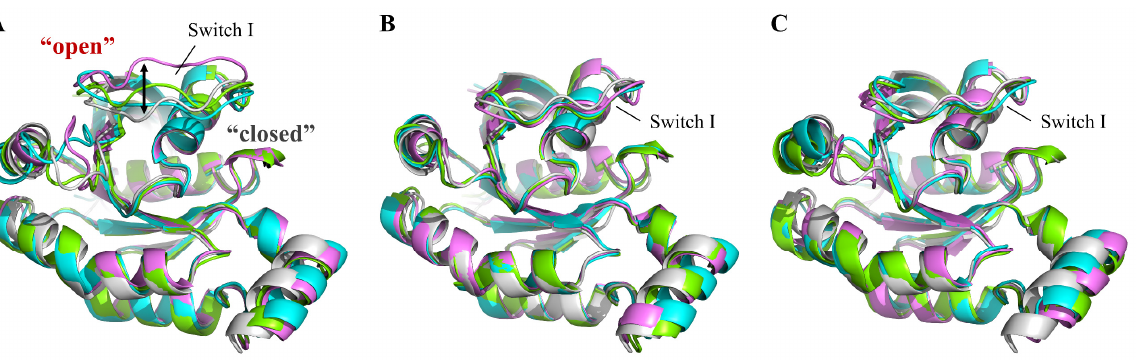
Figure 3. Superimposition of the top-three cluster conformations (cluster1—green; cluster2—cyan; cluster3—violet) of GTP-bound wild-type RhoA ( A ) and the two mutants G14V ( B ) and Q63L ( C ). The initial conformations for each system are also shown here as a gray cartoon.